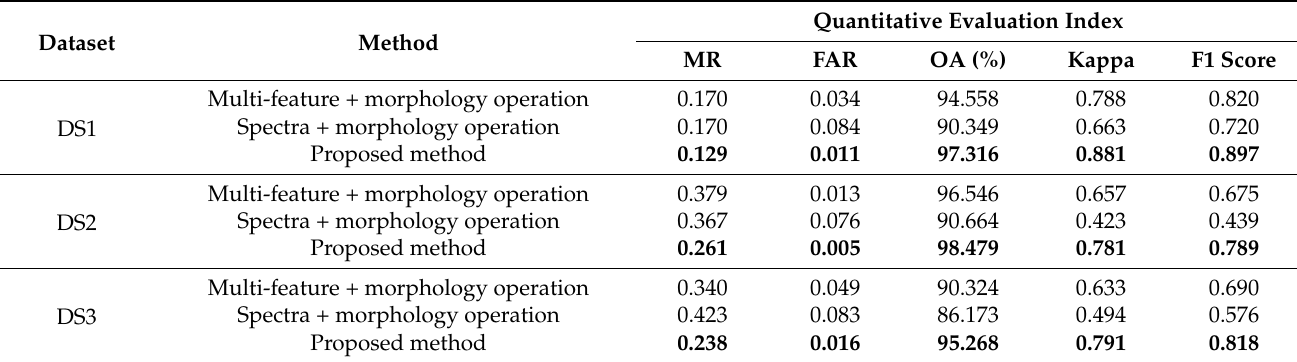
Table 5. Quantitative evaluation of post-processing